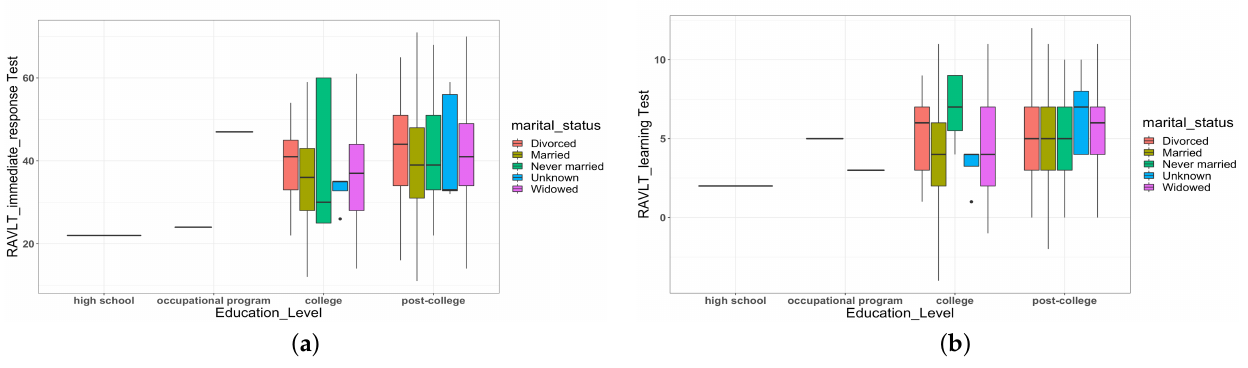
Figure 2. Relatively concentrated distributions of unknown: marital status with college education vs. RAVLT test of immediate response and learning. ( a ) RAVLT immediate response test vs. marital status and education; ( b ) RAVLT Learning test vs. marital status and education.